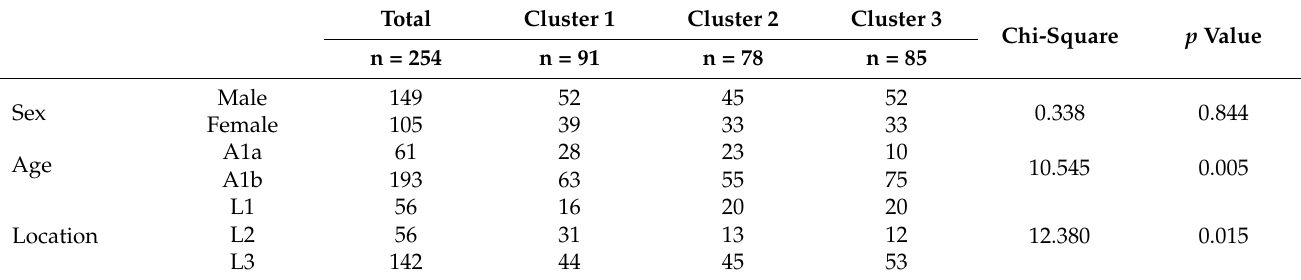
Table 2. Clinical characteristics of patients with distinct